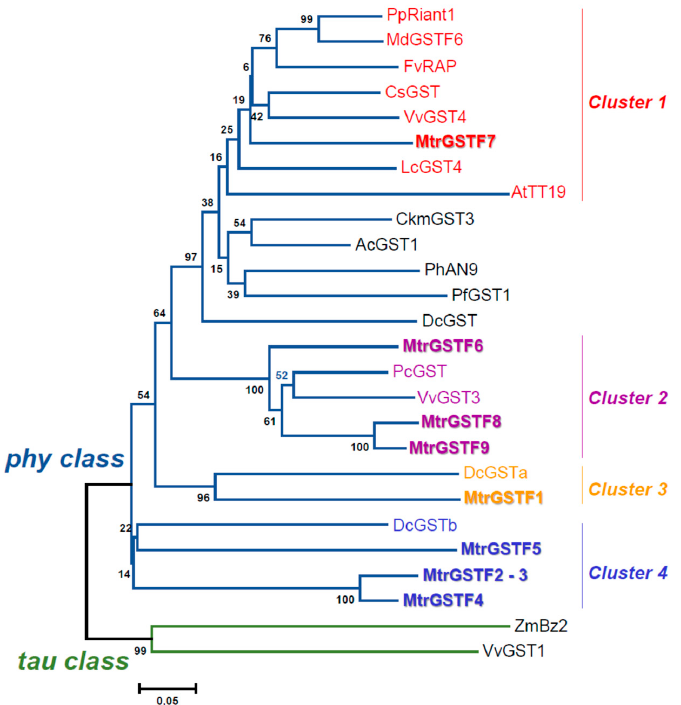
Figure 5. Phylogenetic tree with R108 MtrGSTFs and other GSTs involved in flavonoid